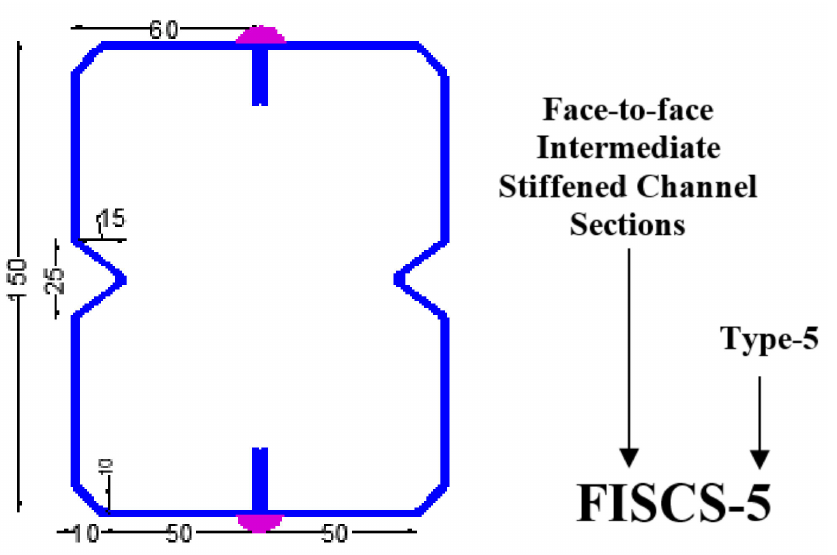
Figure 17. Specimen labelling for parametric studies.